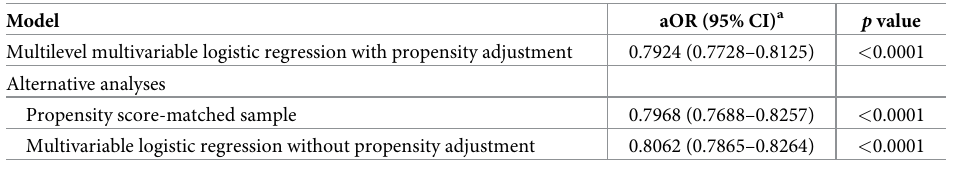
Table 2. Odds ratios for short-term mortality associated with mental